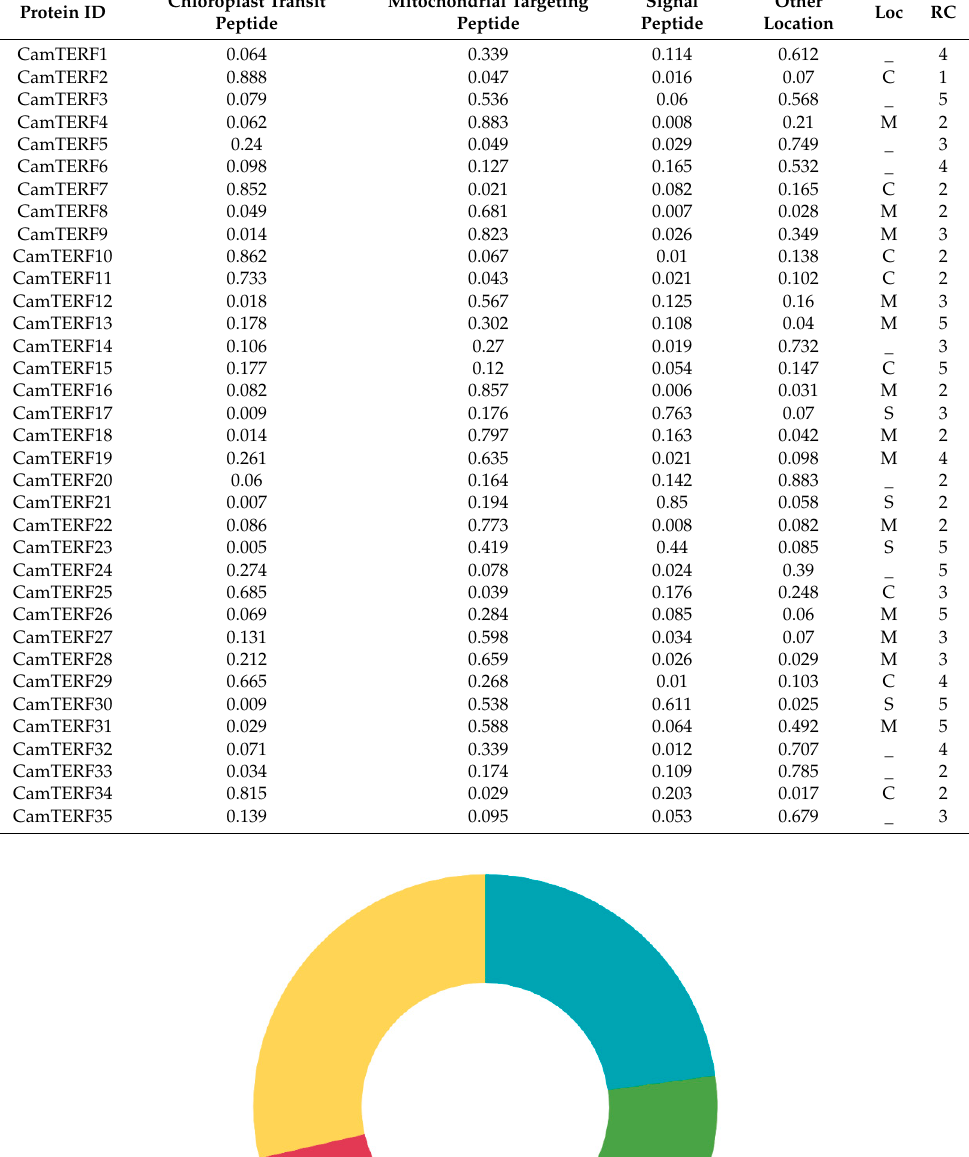
Table 2. Subcellular localization of CamTERFs. Listed are the predicted protein output scores for chloroplast transit peptide (C), mitochondrial targeting peptide (M), signal peptide (S), or any other location (-). Location (Loc) details the subcellular localization predicted based on the prediction scores and reliability class (RC, 1–5) indicates the strength of the prediction, with 1 indicating the strongest prediction. RC is a measure of the size of the di ff erence (‘di ff ’) between the highest (winning) and the second highest output scores.